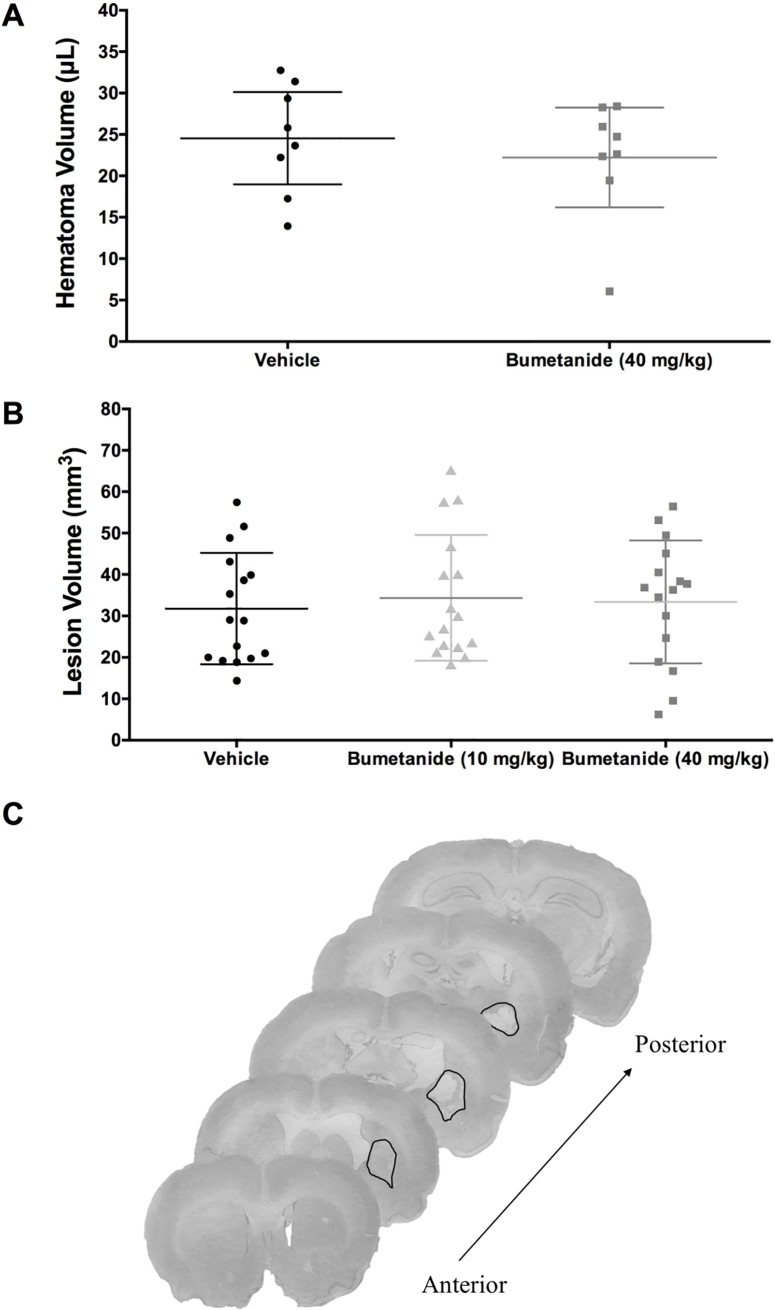
24-hour hematoma volume and 28-day lesion volume.(A) Hematoma volume (μL) data from experiment 1 (n = 8/group) showed that bumetanide did not significantly affect bleeding (P = 0.515). (B) Total tissue loss (mm3), including injury and atrophy, from experiment 6 (n = 16/group) showed that bumetanide did not significantly affect the volume of injury (P = 0.878). (C) Representative histological images at 28 days post-ICH. The black line demarcates the lesion border, and that along with atrophy (e.g., ventriculomegaly) is used to determine tissue loss. This rat, which was in the high dose group, had a total tissue loss of 49.44 mm3. All data presented as mean ± 95% confidence interval.